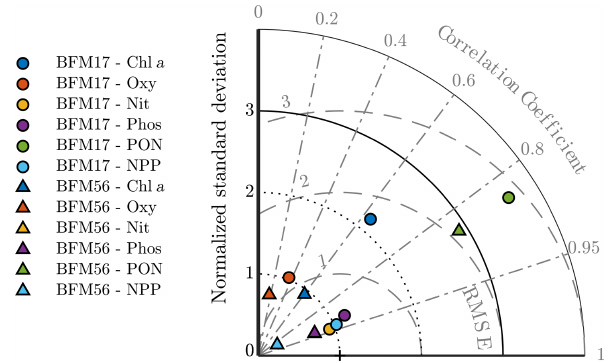
Figure 5. Taylor diagram showing the normalized standard devia- tion, correlation coefficient, and normalized root mean squared dif- ferences between the BFM17 output and the BATS target fields. Observations lie at (1,0). Radial deviations from observations cor- respond to the normalized root mean square error (RMSE), radial deviations from the origin correspond to the normalized standard deviation, and angular deviations from the vertical axis correspond to the correlation coefficient. BFM17 and BFM56 results are shown as colored circles and triangles, respectively (chlorophyll is indi- cated in blue, oxygen is indicated in orange, nitrate is indicated in yellow, phosphate is indicated in purple, PON is indicated in green, and NPP is indicated in cyan). Note that BFM56 nitrate and phos- phate data points fall on top of one another (yellow and purple tri-